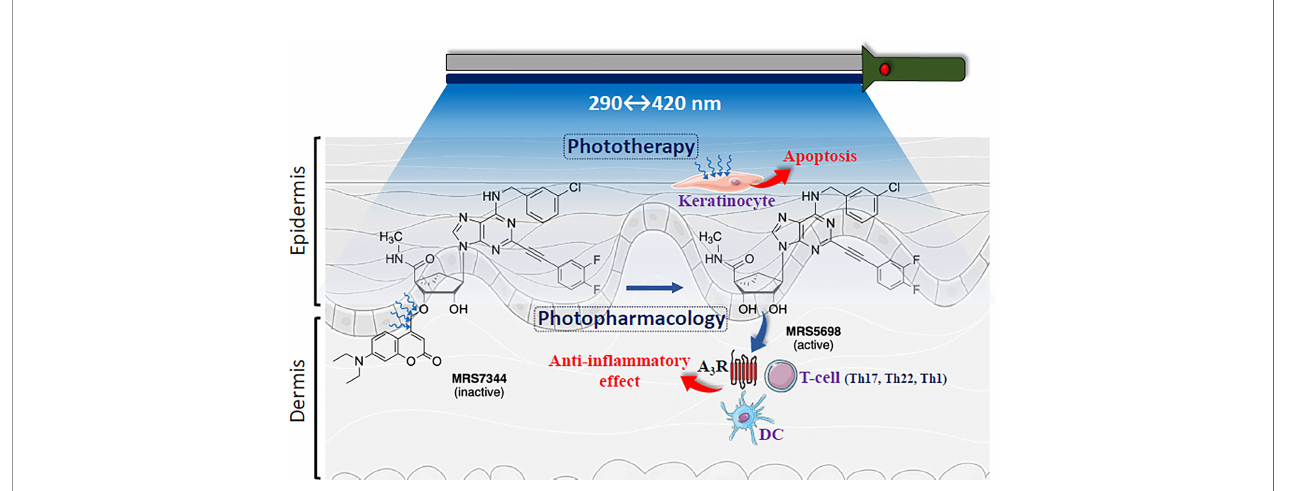
FIGURE 1 | Schematic representation of multimodal phototherapy. Cartoon showing skin layers (i.e., epidermis and dermis) being light irradiated. The structures of highly potent and selective A 3 R agonist MRS5698 and its photocleavable prodrug MRS7344, which is masked as an ether at the 3 ’ -hydroxyl group with a 7- diethylamino-4-hydroxymethylcoumarin (DEAC) moiety is depicted. UV-based light irradiation (290-400 nm) will induce keratinocyte apoptosis (i.e., Phototherapy). In addition, photorelease of MRS5698 with 420 nm may potentially activate A 3 R within immune cells, including T cells (CD8 + , Th17, Th22, Th1) and dendritic cells (DC) (5), thus promoting anti-in fl ammatory effects and alleviating psoriasis. Figure designed using image templates from Servier Medical Art (https://smart.servier.com/